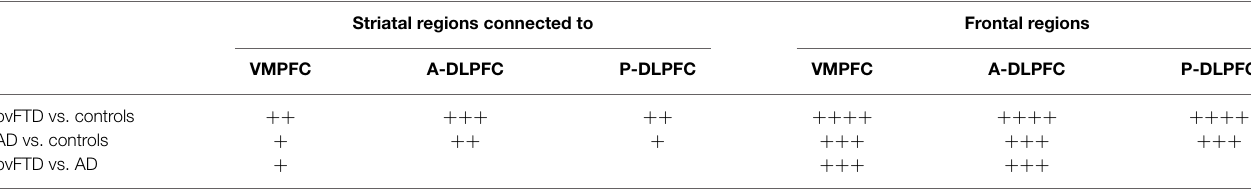
TABLE 2 | Schematic notation of the results in the striatal or frontal regions for the three different imaging contrasts . Striatal regions connected to Frontal regions VMPFC A-DLPFC P-DLPFC VMPFC A-DLPFC P-DLPFC bvFTD vs. controls ++ +++ ++ ++++ ++++ ++++ AD vs. controls